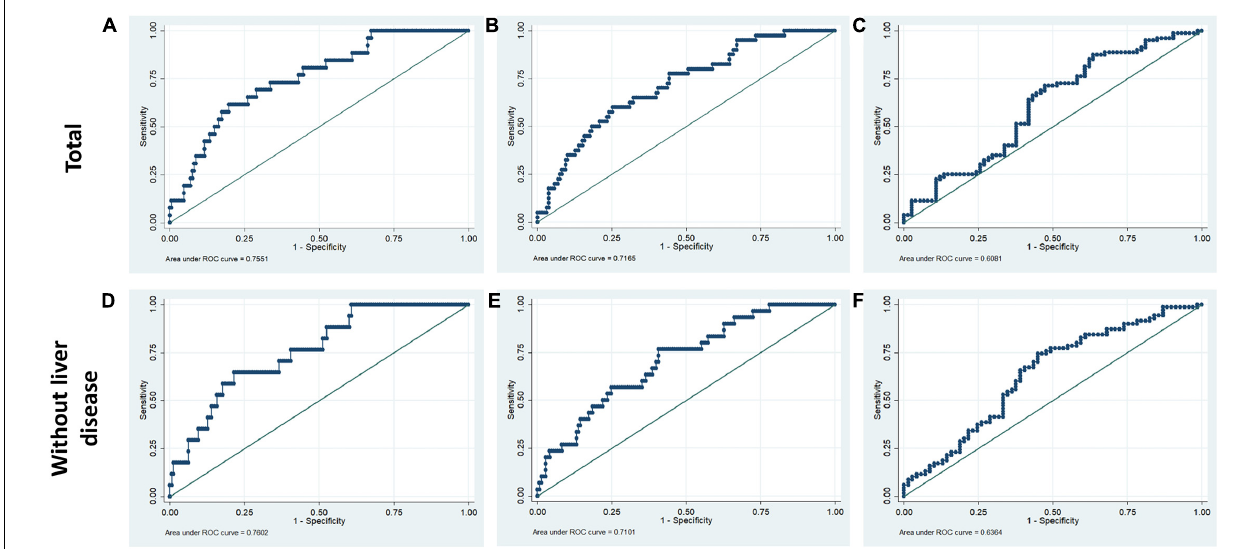
FIGURE 5 | Receiver operating characteristic curves for liver function tests in hospital mortality, 90-day mortality, and 4-year mortality of patients with PPH. The ROC included ALB, ALT, AST, and total bilirubin. (A,D) Hospital mortality; (B,E) 90-day mortality; (C,F) 4-year mortality. (A–C) Total patients with PPH. (D–F) Patients with PPH and without liver